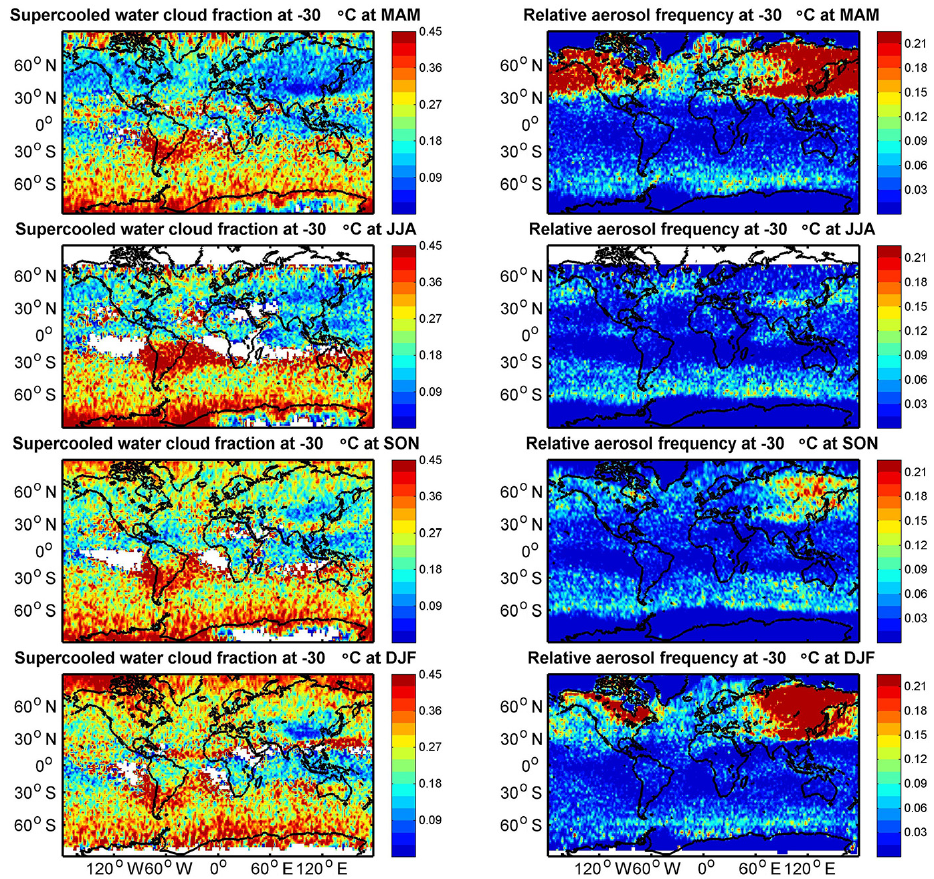
Figure 3. The global and seasonal variations of supercooled water cloud fractions (SCFs) and relative aerosol frequencies (RAFs) during nighttime at − 30 ◦ C isotherm over 2 ◦ × 2 ◦ grid